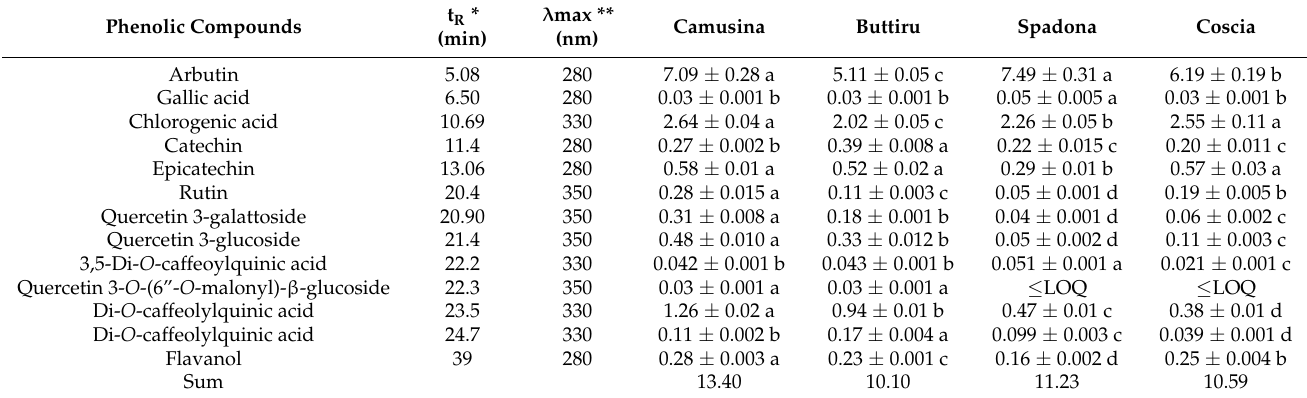
Table 8. HPLC analysis of individual phenolic compounds (mg g − 1 DM) in the fruit peduncle of the investigated pear